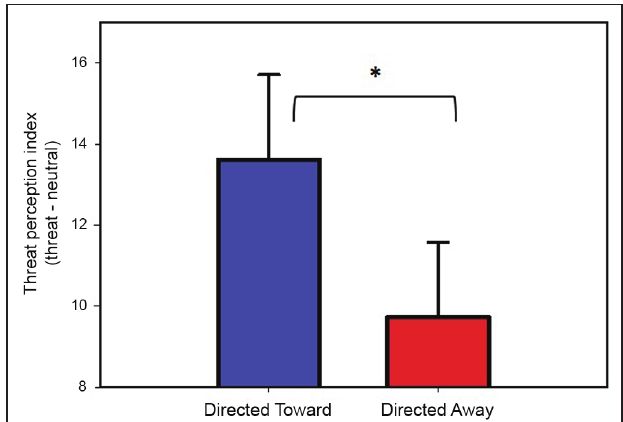
FIGURE 2 | Threat perception ratings. Values represent the threat perception index (Threat-Neutral ratings) per block. Both bars represent the mean values, and error bars indicate the SEM. * Indicates a significant difference.